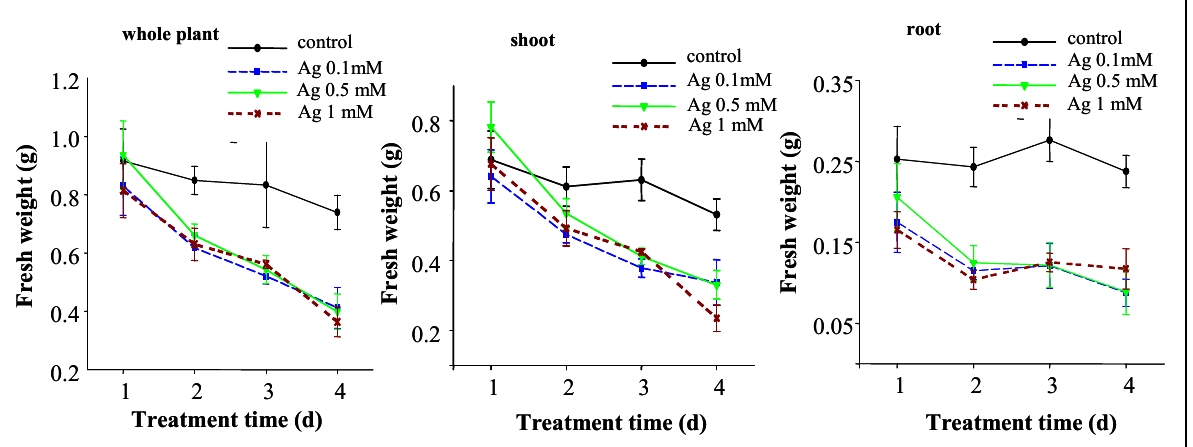
Figure 4. Fresh weight changes (whole plant, shoot and root) of sunflower plants exposed to various doses of silver(I) ions for 96